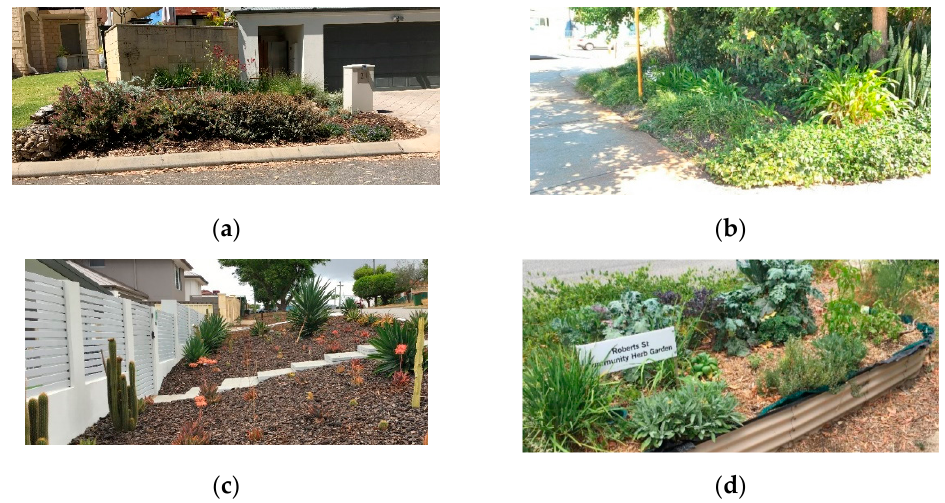
Figure 5. ( a ) Example of a native verge garden; ( b ) example of an ornamental garden with exotic